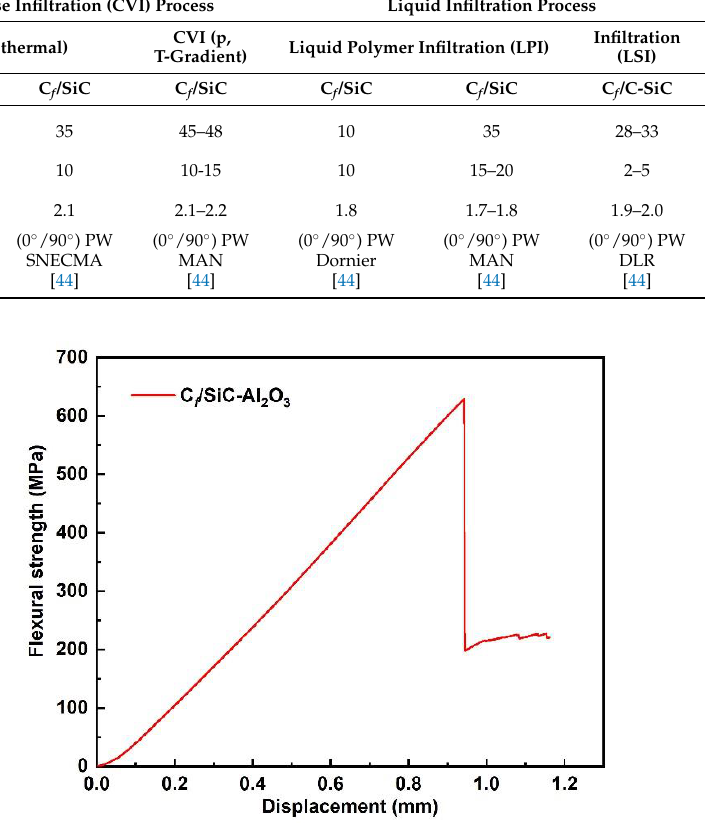
Figure 8. Typical flexural strength displacement curve of the C f /SiC-Al 2 O 3 composite.